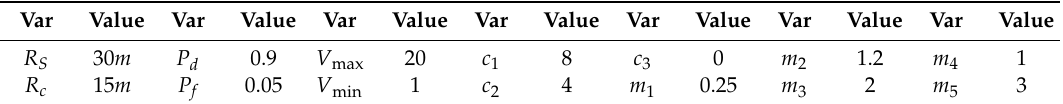
Table 4. Variable